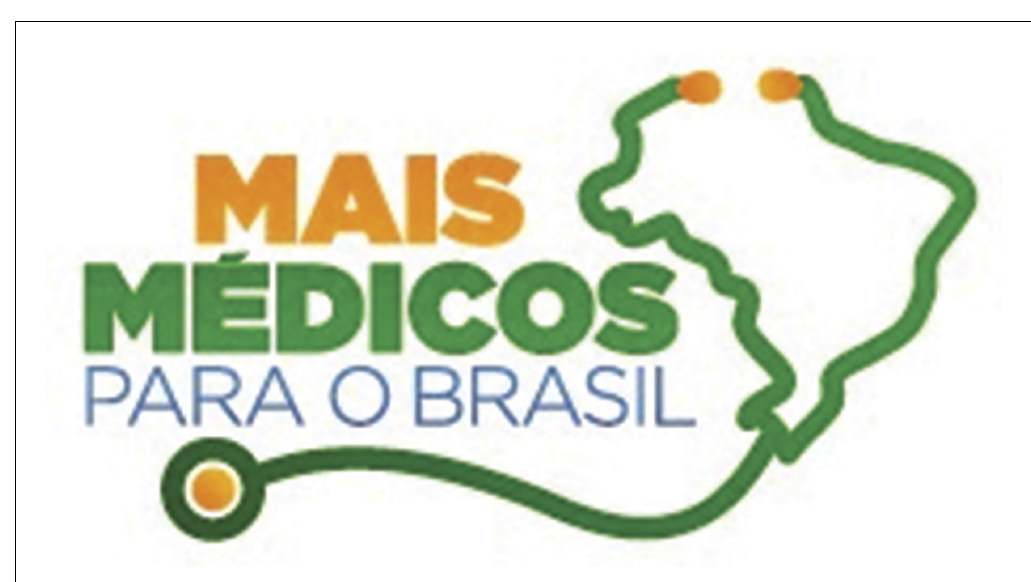
Figure 1. More Doctors